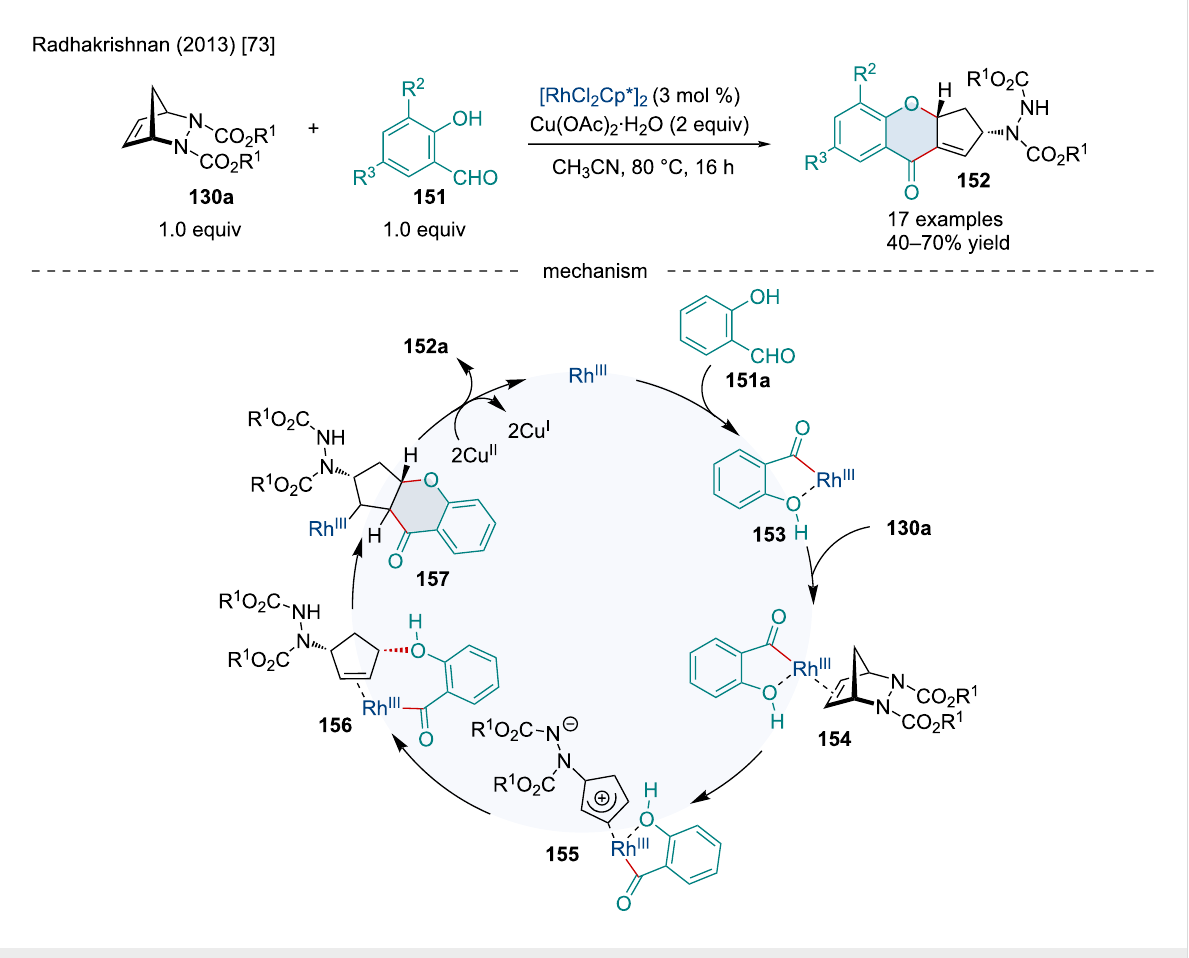
species, by AgSbF 6 and Cu(OAc) 2 , which oxidatively